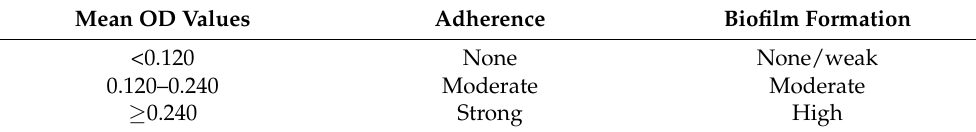
Table 1. Characterization of TCP